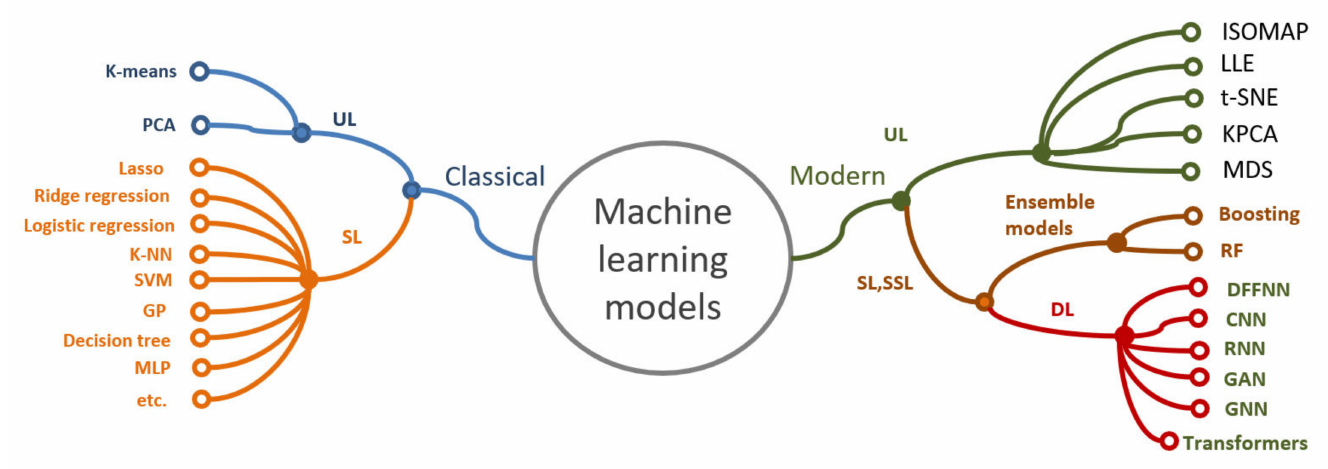
Figure 4. Classic and modern ML models. Source: generated by the